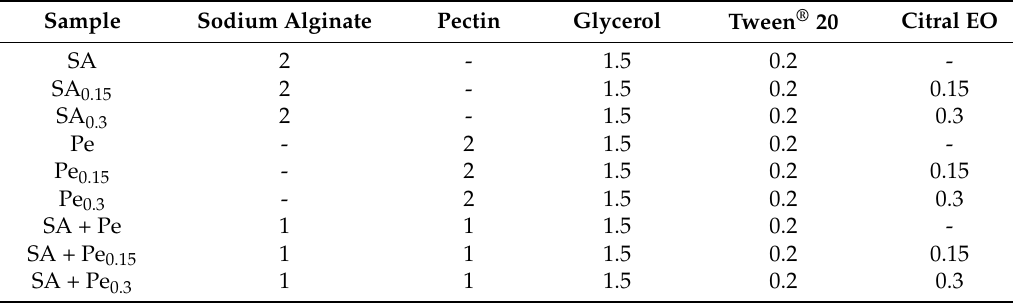
Table 1. Concentration (w/w %) of the components in the film forming